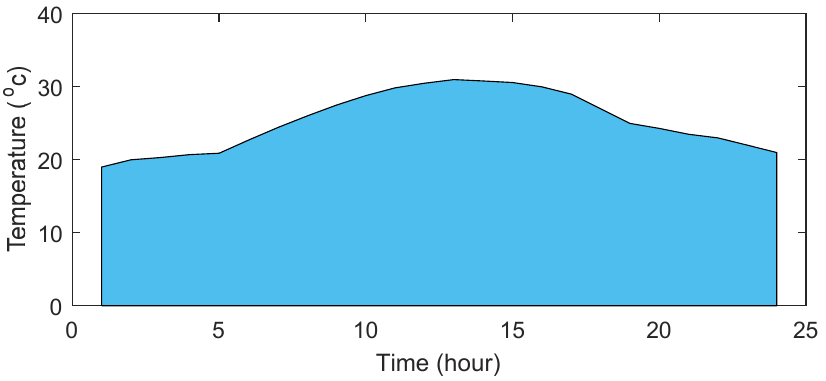
Figure 5. Ambient temperature during a day for Gorgan Figure 6. Ambient temperature during a day for Gorgan region. Figure 6. Ambient temperature during a day for Gorgan region.